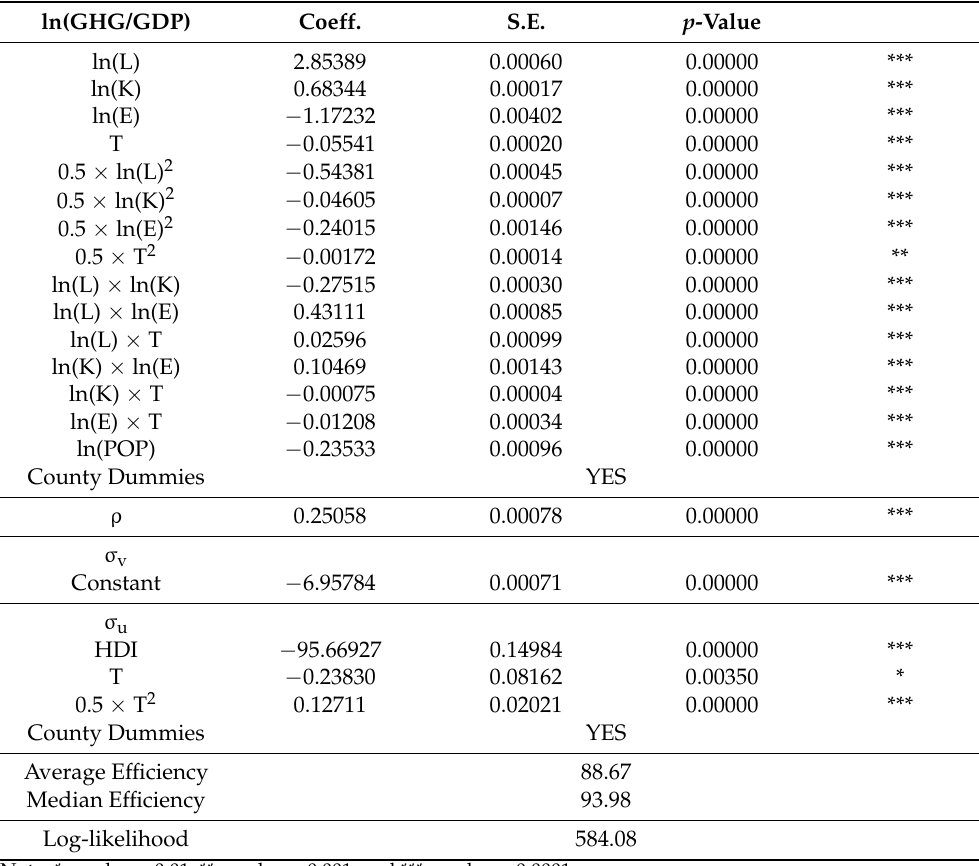
Table 2. SAR Stochastic Frontier GHG Emission Efficiency Model Estimates.